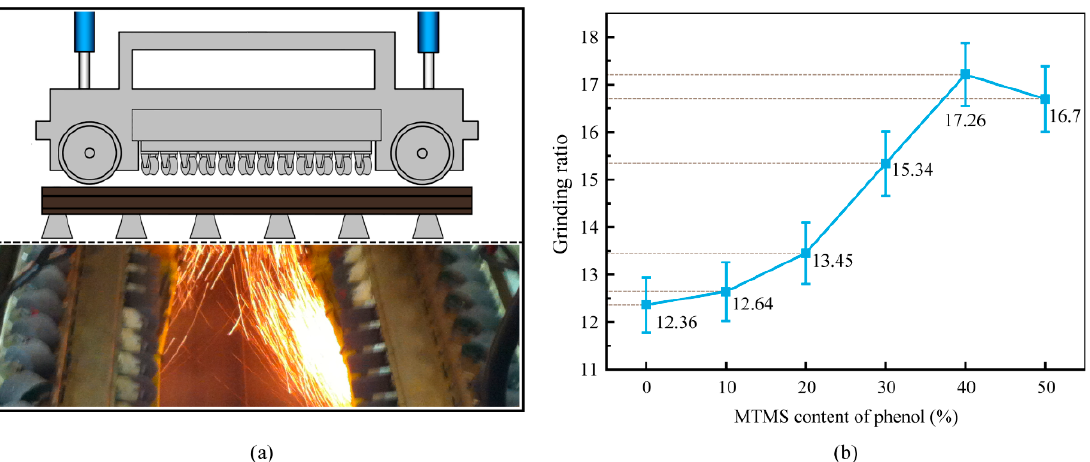
Figure 13. ( a ) The structure and grinding process of the HSG rail grinding mechanism; ( b ) the grind- ing ratio of the rail grinding wheels manufactured with silicone-modified phenolic resins containing different MTMS.